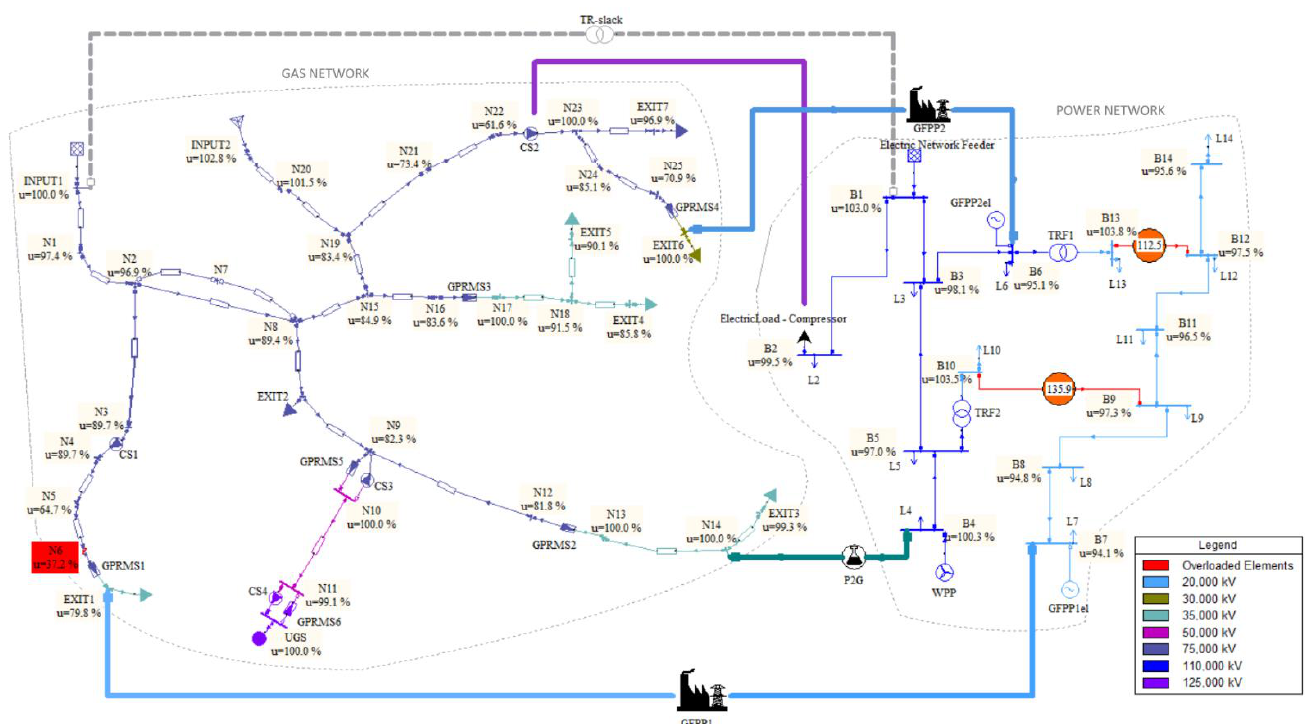
Figure 5. Analyze the influences of the CS1 operation state on the security of the power network supply UGS injection process.